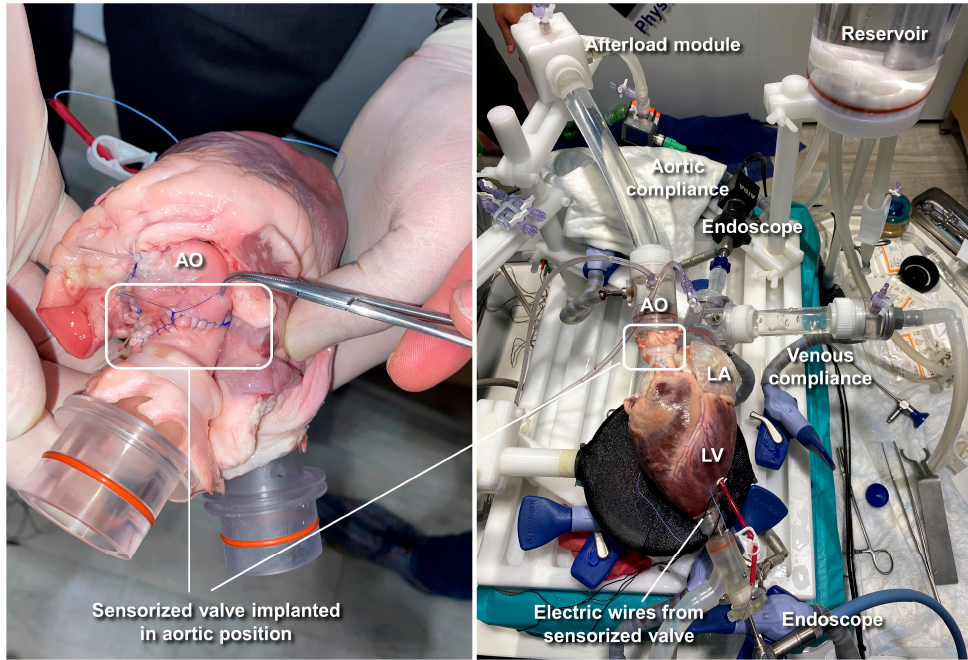
Figure 4. Cardiac BioSimulator platform used for the ex vivo animal testing of the sensorized BHV. AO = aorta; LA = left atrium; LV = left ventricle.